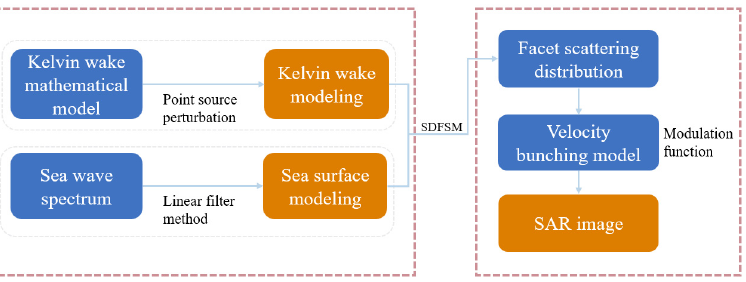
Figure 6. Simulation flow chart of ship wake SAR image in sea background.